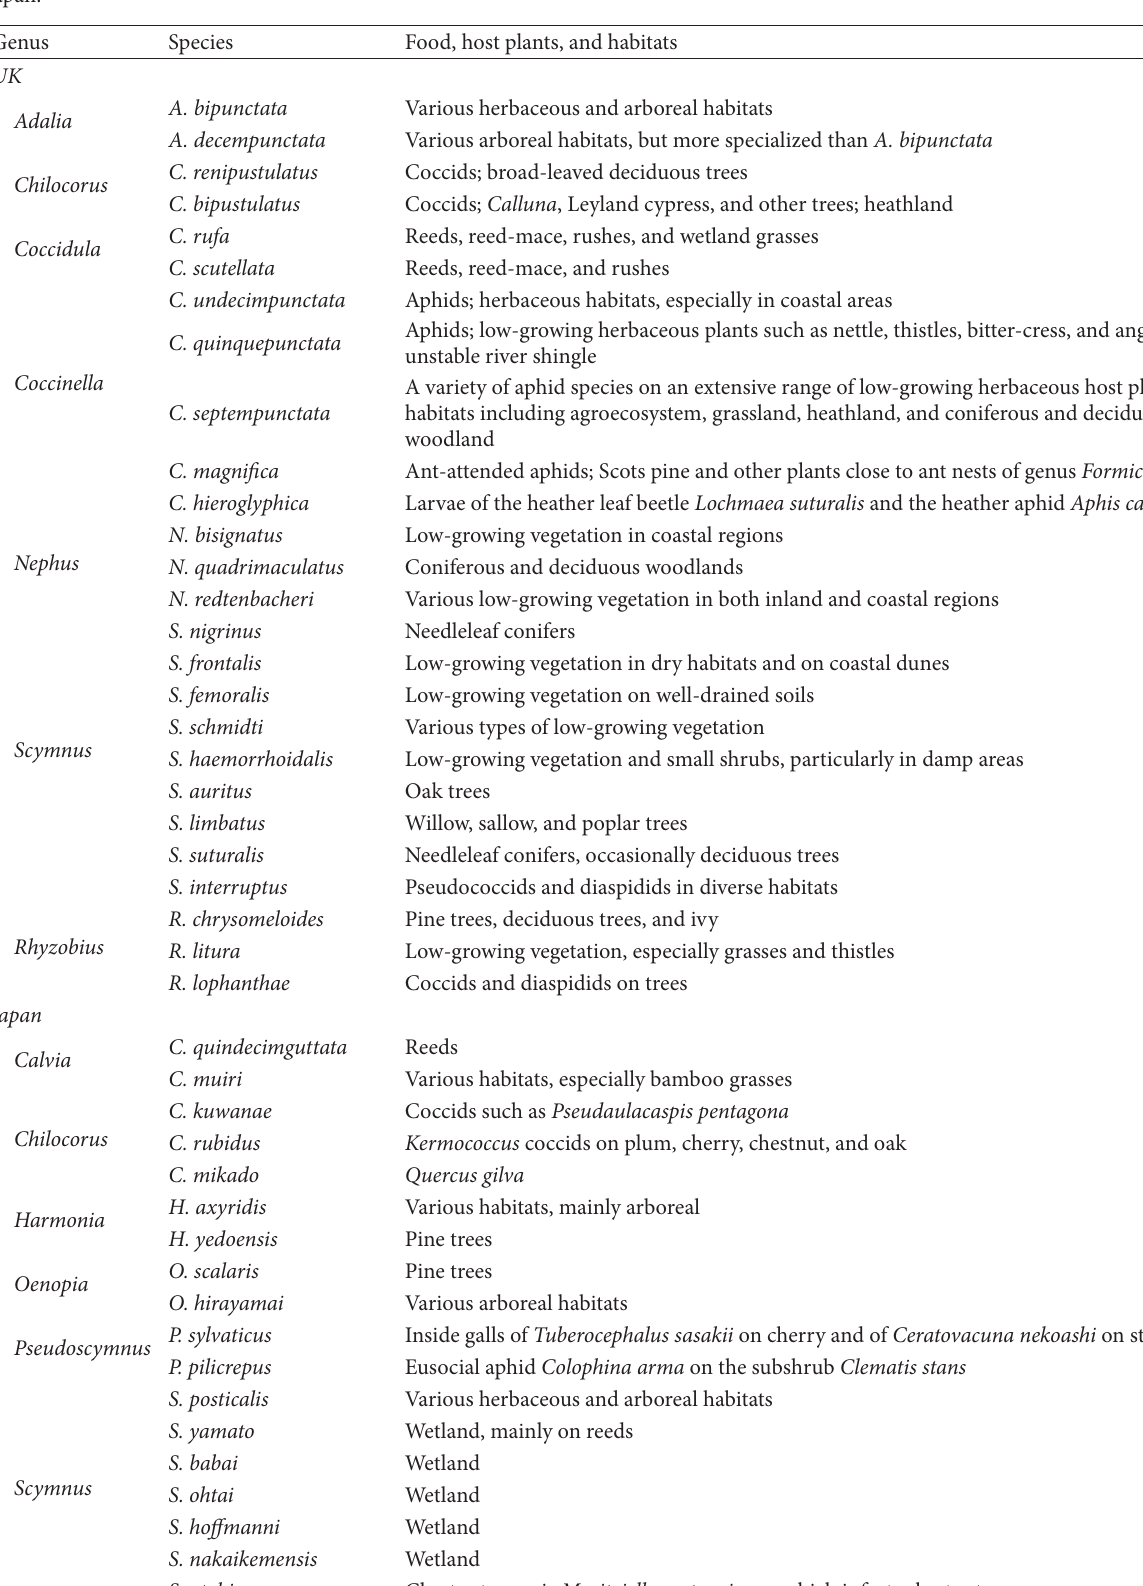
Table 2: Comparison of niche utilization among sympatrically distributed congeneric ladybird species of the United Kingdom (UK) and